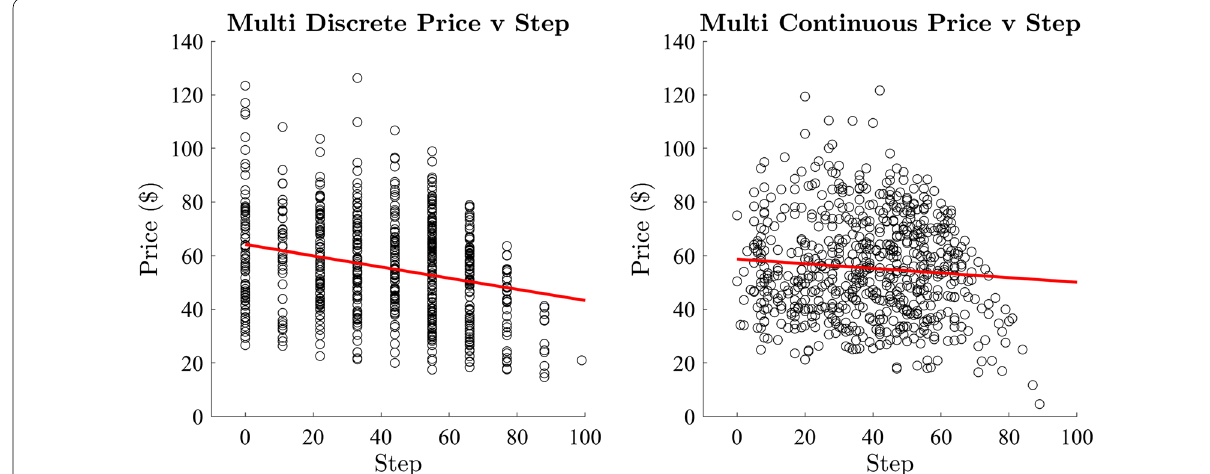
Fig. 9 Exp 2: correlation of the price and step of winning bids